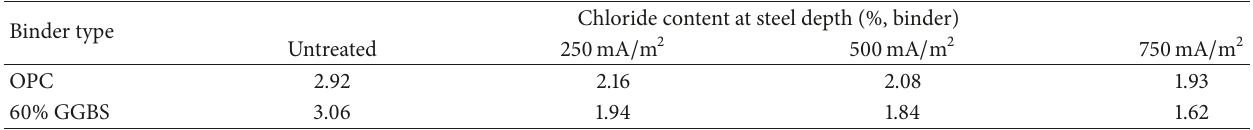
Table 3: Average of chloride contents at steel depth after electrochemical treatment depending on the applied current densities and binder